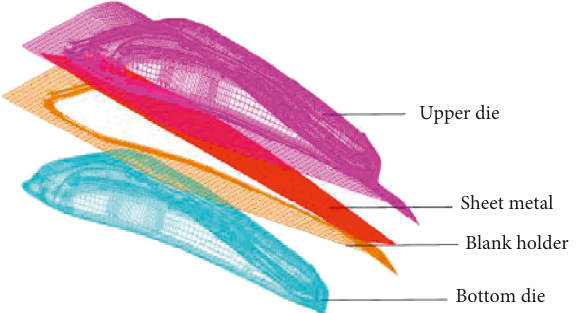
Table 4: Influence of various factors on maximum thinning rate.